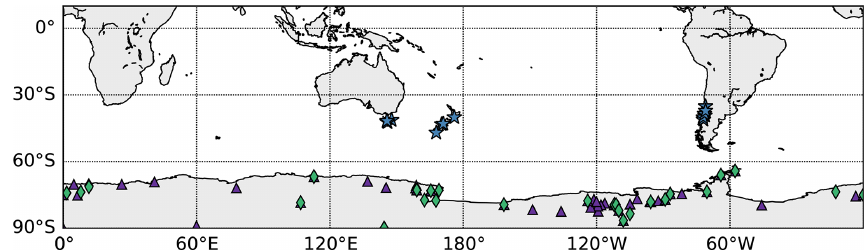
Figure 1. Location of the 15 tree-ring width (TRW) records (blue stars) from the PAGES 2k databases (PAGES 2k Consortium, 2013, 2017) used in this study: the 49 ice core snow accumulation records (purple triangles) from Thomas et al. (2017) and Medley et al. (2018) as well as the 29 δ 18 O records (green diamonds) from Stenni et al. (2017) (Sect. 2.3). Background map from Hunter (2007).